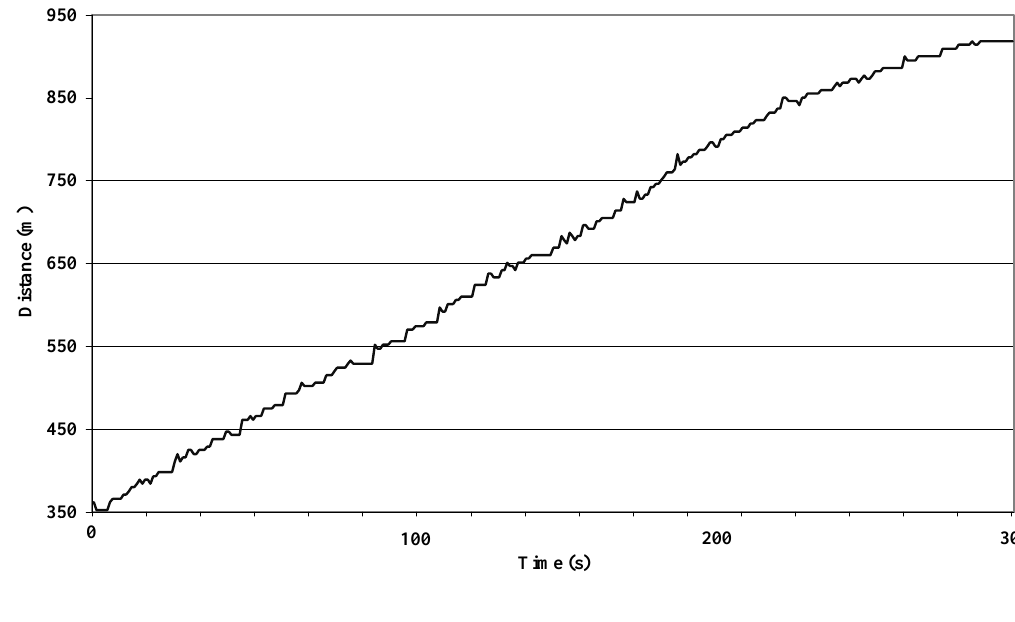
Figure 6. Test line of the Paris metro: Measured distance versus